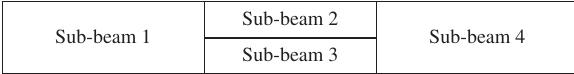
Figure 2 Representation of beam with delamination into four sub-